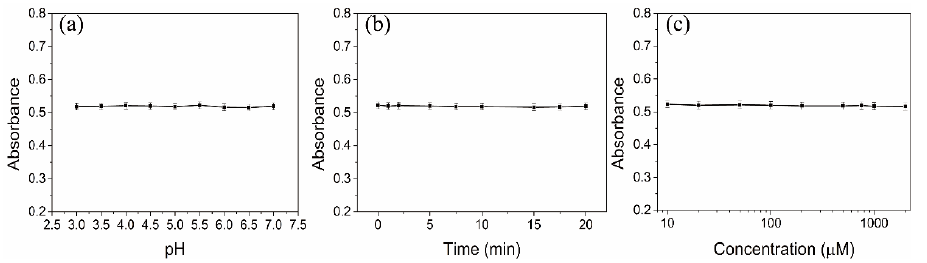
Figure 4. Evaluation of stability of DTT-AuNRs colorimetric probe: ( a ) Effect of the pH value of NaAc-HAc buffer (10 mM); ( b ) Effect of the reaction time; ( c ) Effect of the concentration of NaCl.